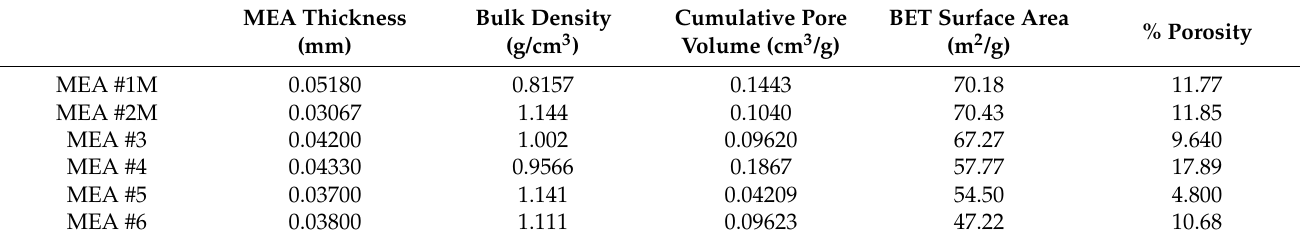
Table 3. The thickness and pore characteristics of the monolayer and stratified CCL